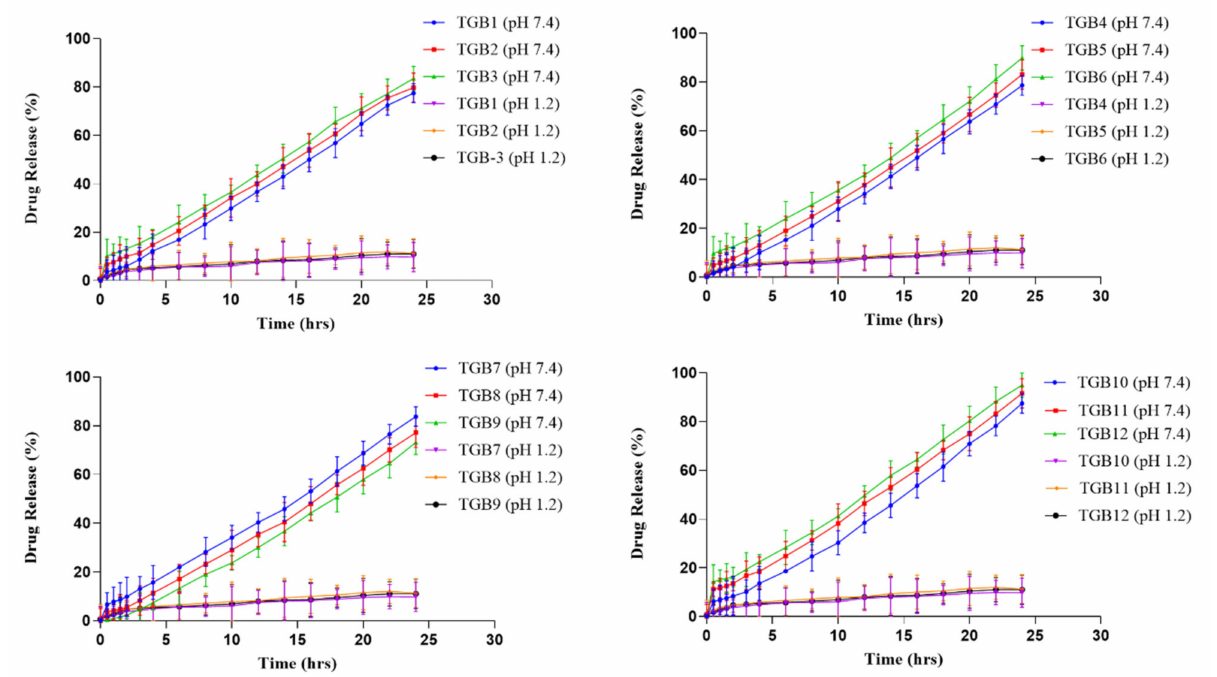
Figure 11. Results of ACV release from developed formulations